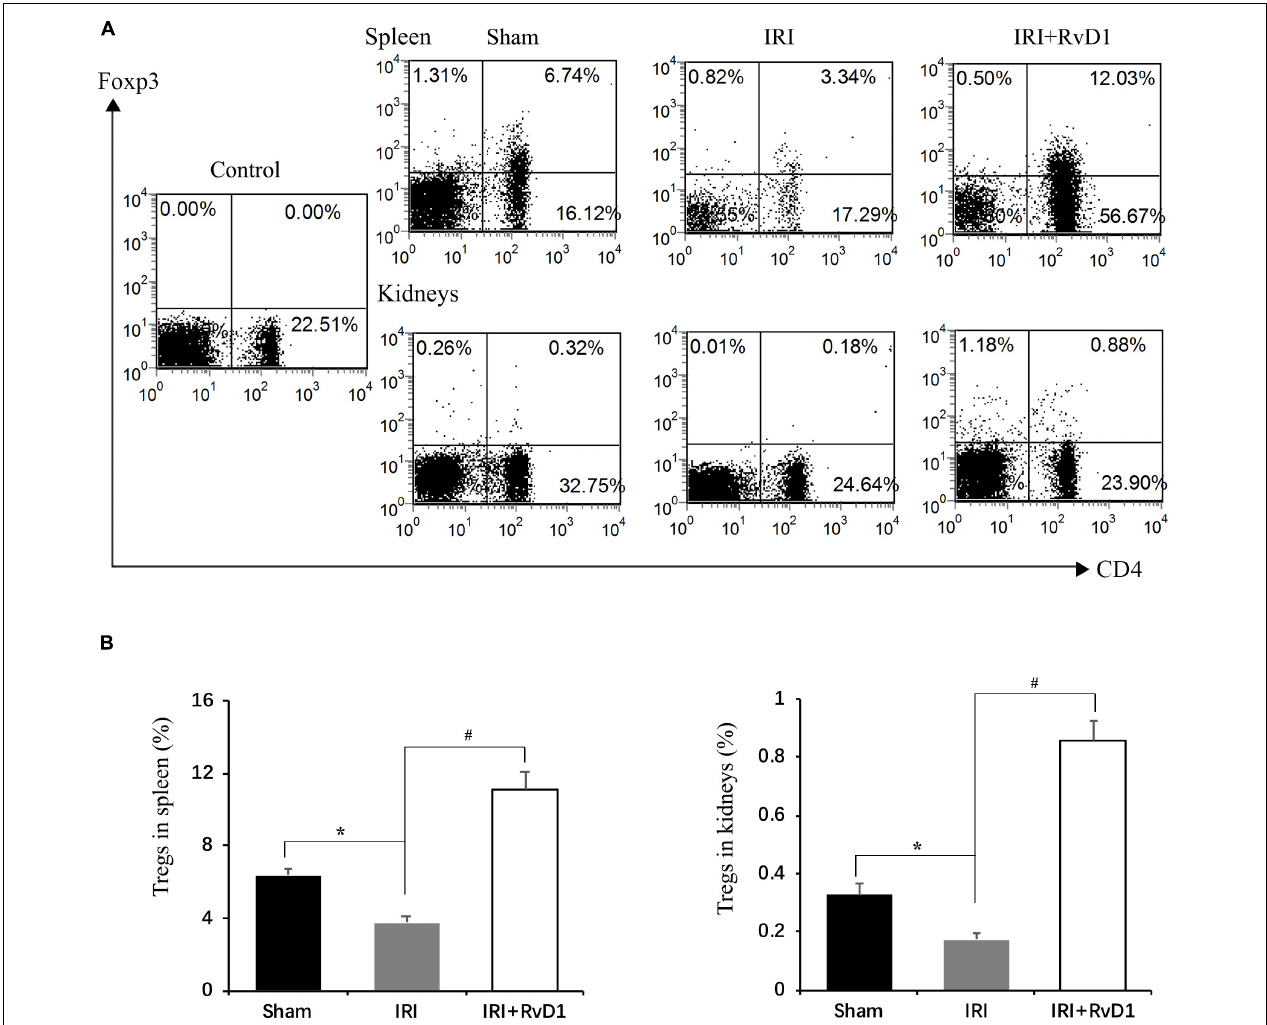
FIGURE 2 | RvD1 increased the percentages of Tregs in IRI-AKI mice. At 72 h after reperfusion, single-cell suspensions were harvested from splenocytes and kidney cells. (A) Representative flow cytometry analysis of CD4 + Foxp3 + T cells obtained from the spleen or kidneys in IRI-AKI mice. The plots are gated for CD4 + lymphocytes. The data are representative of 3 independent experiments. (B) Percentages of CD4 + Foxp3 + T cells in the spleen and kidneys of IRI-AKI mice. Values are expressed as the means ± SDs, n = 6–8 per group. * P < 0.05 versus sham; # P < 0.05 versus